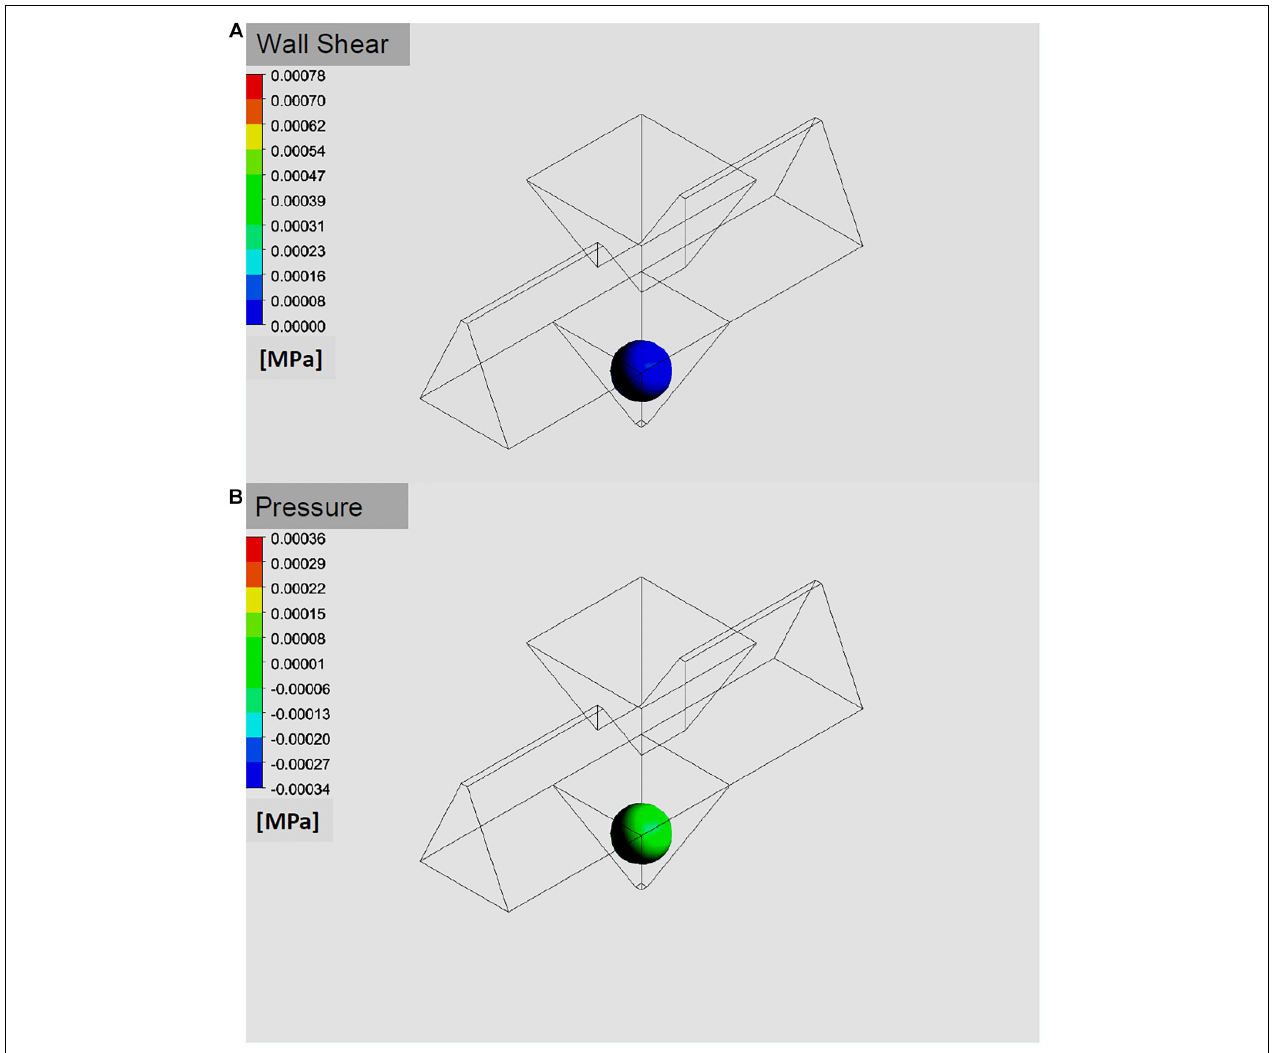
FIGURE 6 | Simulation of pressure and shear stress exerted on an islet in the well. The benefit of a fast medium exchange has to be weighed against the forces exerted on the islet in the well. The simulation of pressure (A) and of shear stress (B) on the surface of a 150 µ m islet suggests that only minimal mechanical force is exerted at the flow rates used for the simulations and the experiments (40 µ